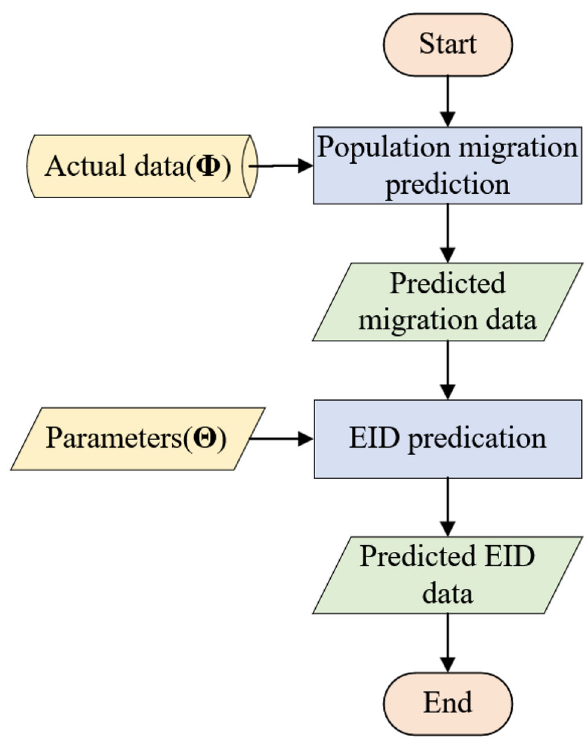
Fig. 3 Flow chart of the prediction module